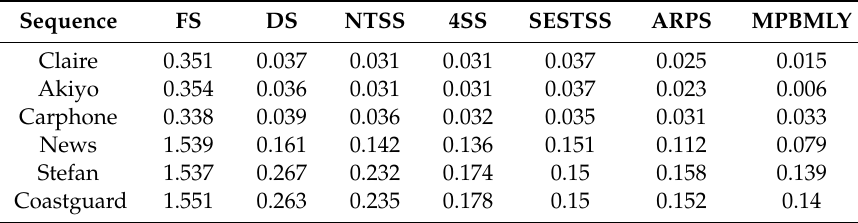
Table 6. Time needed to process 50 frames (second).